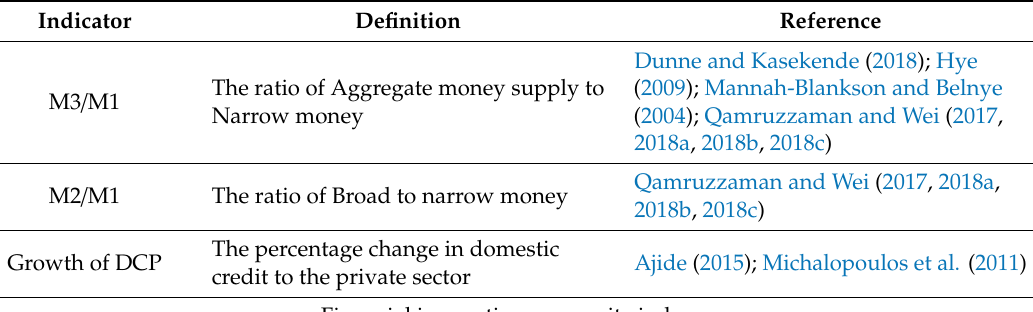
Table A1. Financial innovation proxy